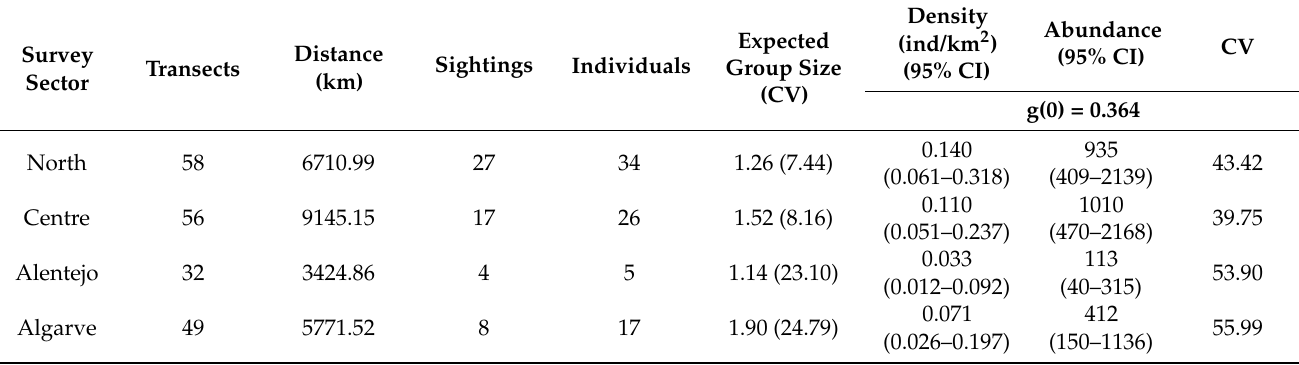
Table 3. Harbour porpoise abundance and density estimates, using g(0) = 0.364 [15], in the different sectors in Portugal during the study period. Survey effort (number of transects and length, in km), no. of harbour porpoise sightings and individuals, and expected group size. Coefficient of variation (CV, %) and confidence interval (CI) were estimated considering the 5-year sampling period.